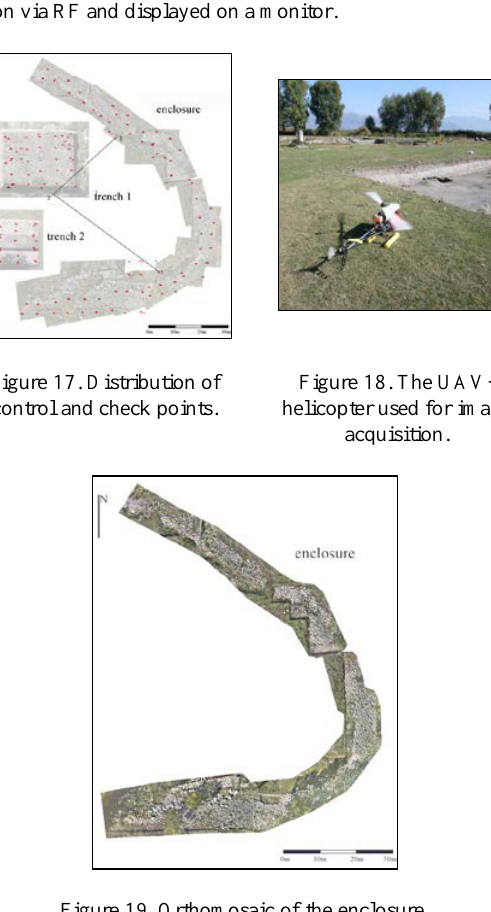
Figure 16. Failed effort while creating an orthophoto, a. initial image, b. final orthophoto.